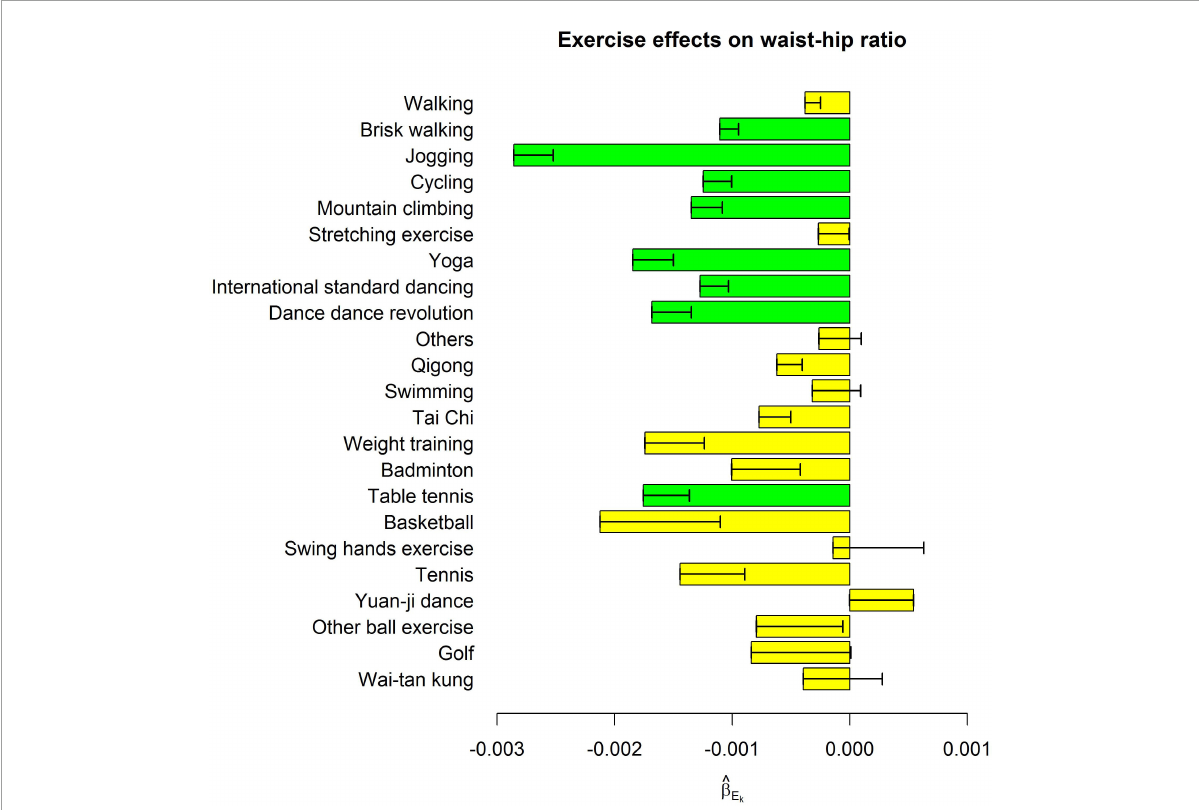
FIGURE3 Exercise main effects on waist-hip ratio. The bars represent ˆ β E ... , 23. Bars with p < 0.0004 = 0.05/(23 × 5) were highlighted in green